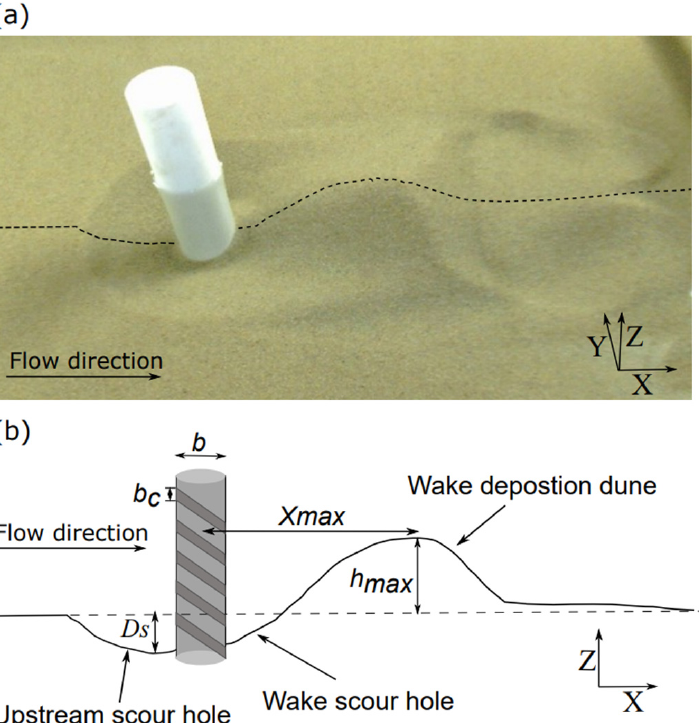
Figure 2. ( a ) Photograph of the scour pattern for the control pier without cable with sediment size d 50 = 0.86 mm. ( b ) outline of the centerline of the bedforms at 12 h with a protected pier of diameter b and cable diameter b c illustrated, and dimensions of the scour hole depth ( D s ), the wake deposition dune peak height ( h max ) and its longitudinal distance downstream of the pier ( X max ).